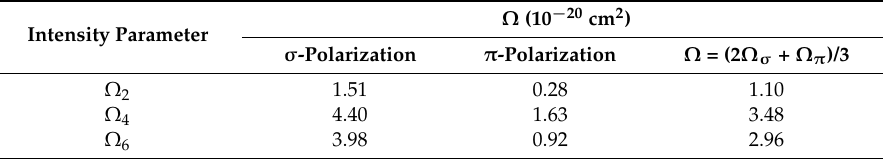
Table 2. The J–O intensity parameters of the Nd:ASL crystal.